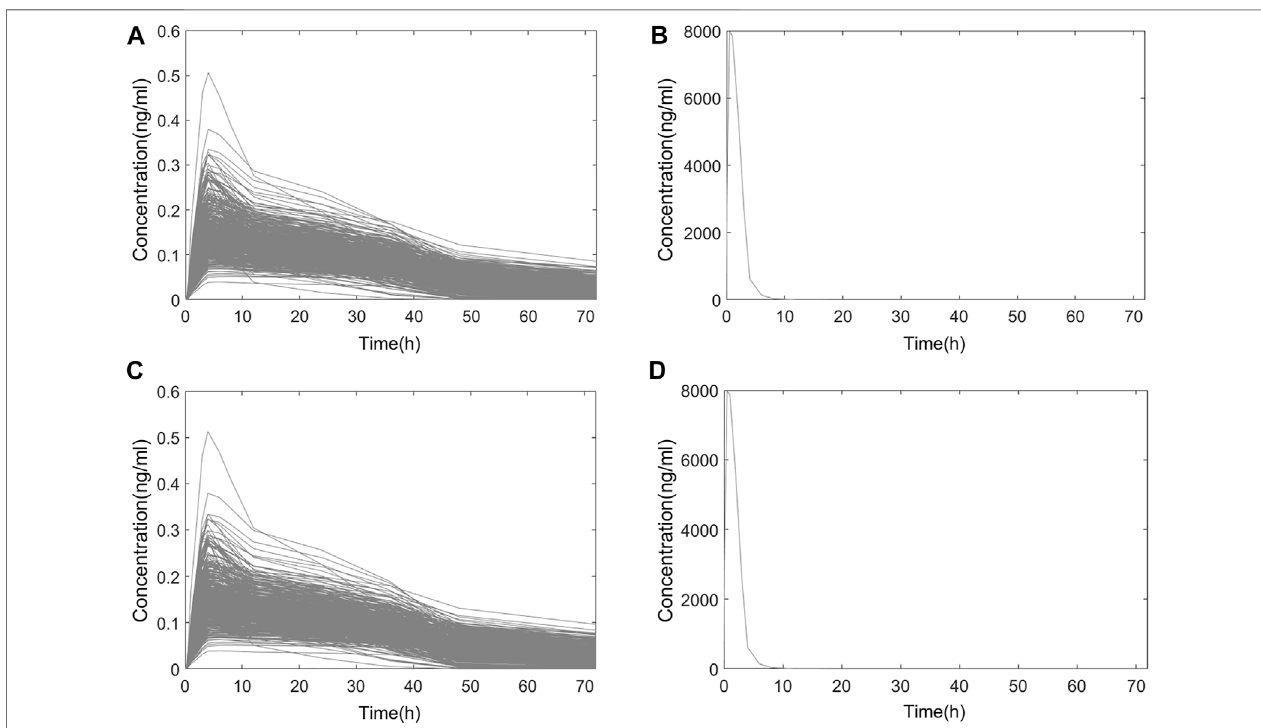
FIGURE 6| Simulated PK curve of single-dose administration. (A) Systemic PK in Chinese; (B) nasalPK in Chinese; (C) systemicPK in Americans; (D) nasal PK in Americans.